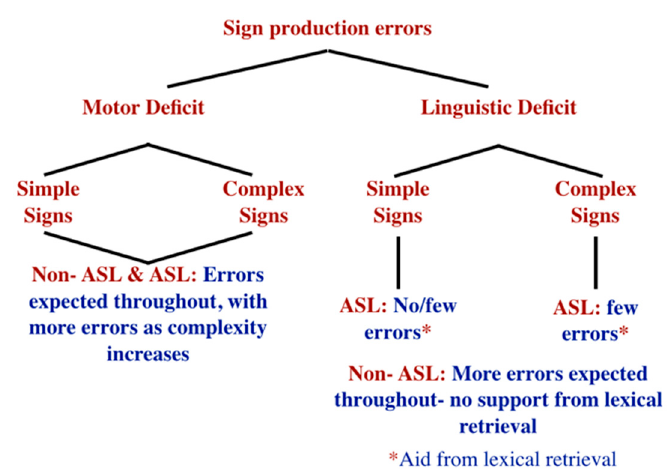
/ non-sign copying task, based on domain of Figure 1. Predicted performance on sign/non-sign copying task, based on domain of deficit. Figure 1. Predicted performance on sign